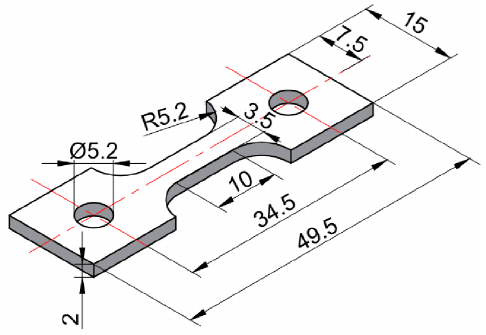
Figure 1. The dimensions of tensile specimens used in this study (unit: mm).